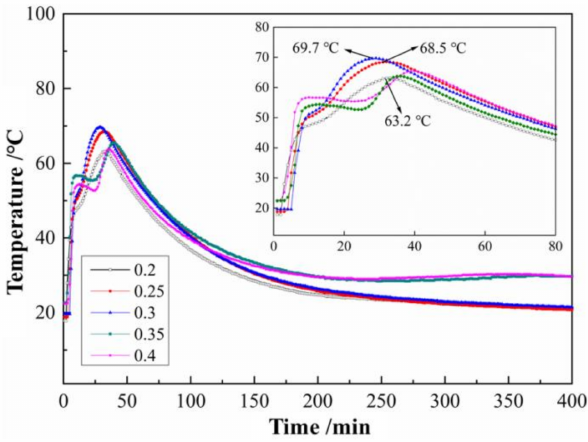
Figure 4. Influence of W/C ratios on the hydration heat release characteristics of SLMKPC slurry. When W/C < 0.3, only one exothermic peak was detected and the maximum exother- mic peak temperatures corresponding to W/C = 0.2, 0.25, and 0.3 were 63.2 ◦ C, 68.5 ◦ C, and 69.7 ◦ C, respectively. It implies that the hydration reaction of SLMKPC became more violent in the W/C range of 0.2–0.3. When W/C = 0.2, the moisture content in the